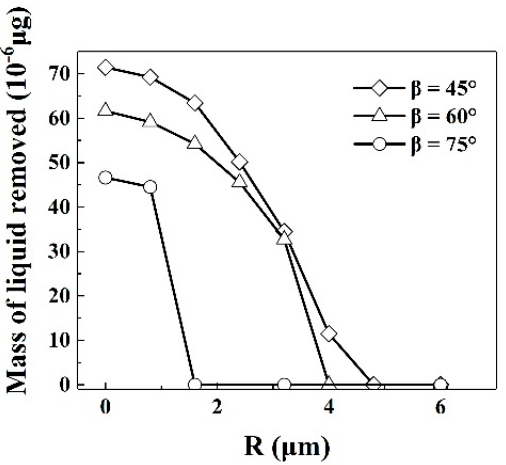
Figure 12. The relationship between the fillet radius and mass of residual liquid. The fillet radius was further studied under the parameters of α = 30 ◦ , β = 60 ◦ , and h = 12 µ m. From the transfer process of liquid in the cells with different fillet radius at liquid residue in the cell corners. In addition, the size of the fillet radius significantly the bottom of the cell (B t ) and thickness of the thinnest part of the liquid (S t ) with the